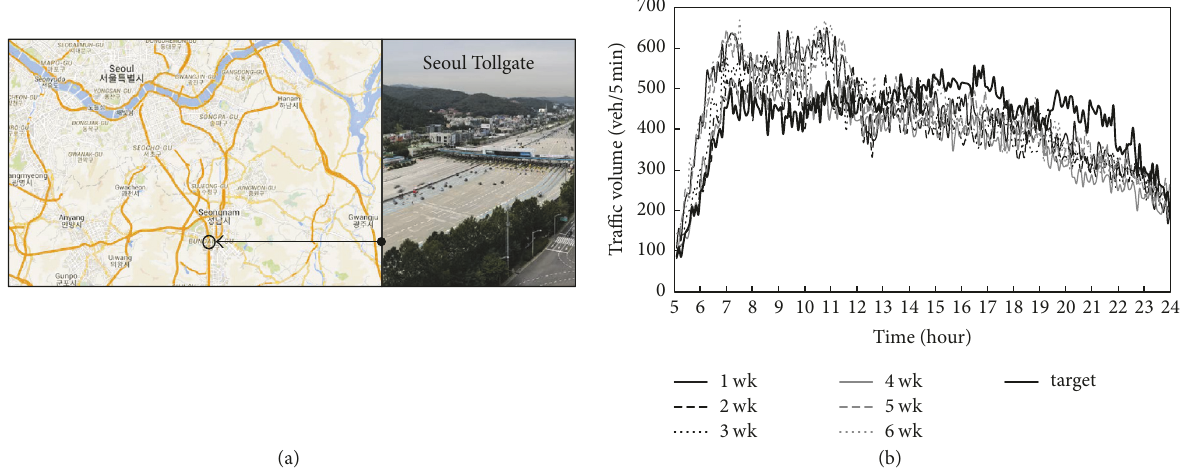
Figure 2: Information of target traffic volume data. (a) Test bed (source: Google Maps) and (b) temporal state evolution of the target